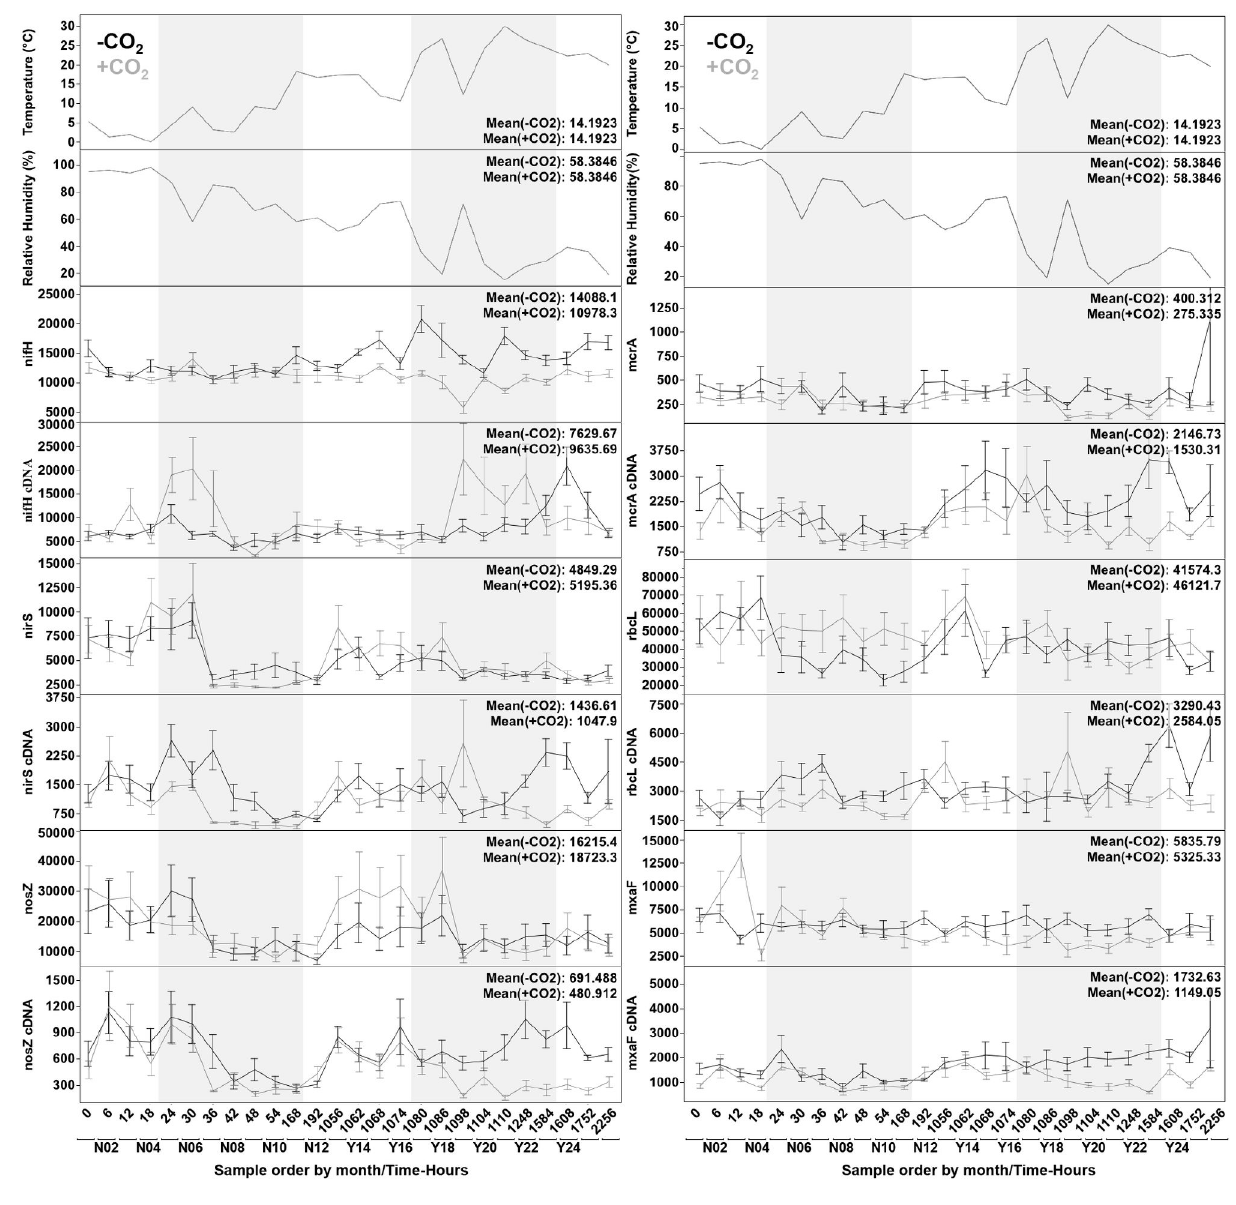
Figure 1. Community response to CO exposure over time. Plot of atmospheric temperature, relative humidity, gene 2 abundance and transcript abundance at time of sampling for six functional genes involved in nitrogen (left panel) and carbon (right panel) cycling under simulated CO leakage (grey lines) or background (black lines) conditions. Data is presented sequentially by 2 month (N=June, Y=July-Sept) and by hours from start of the experiment. Grey-shaded bars indicate active CO flux (injections) for 2 June and July. Values indicate copy numbers per 5 ng of nucleic acid based on averaged measurements of separate triplicate extractions and at least triplicate qPCR reactions for each extraction (n≥9). Error bars are one standard error of the mean (SE). nifH : nitrogenase gene; nosZ : nitrous oxide reductase gene; nirS : nitrite reductase gene; rbcL : ribulose-1,5-bisphosphate carboxylase oxygenase (RuBisCO); mxaF : methanol dehydrogenase; mcrA : methyl-coenzyme M reductase.